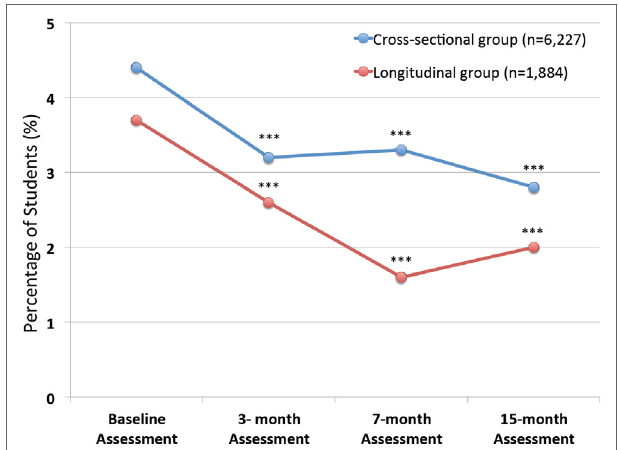
FigUre 3 | Percentage of students deemed “actively suicidal” at each assessment . Shows the percentage of students who were deemed “actively suicidal” according to defined criteria at each assessment. Data are shown both for cross-sectional group of 6,227 who completed at least one of the 4 assessments (Baseline n = 3,244; 3-month assessment n = 3,228; 7-month assessment n = 4,856; and 15-month assessment n = 4,496), as well as for the 1,884 students who completed all 4 assessments and consist of the longitudinal group. It can be seen that there are highly significant differences from baseline assessments in both groups at all subsequent assessments (*** p <